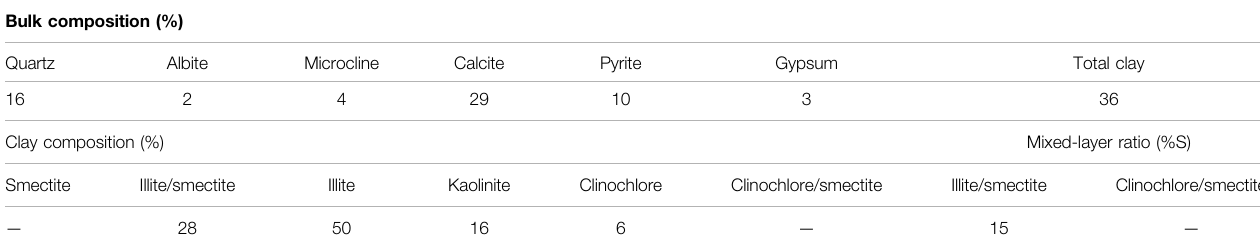
TABLE 3 | Bulk-rock and clay mineral compositions of fault gouge sample